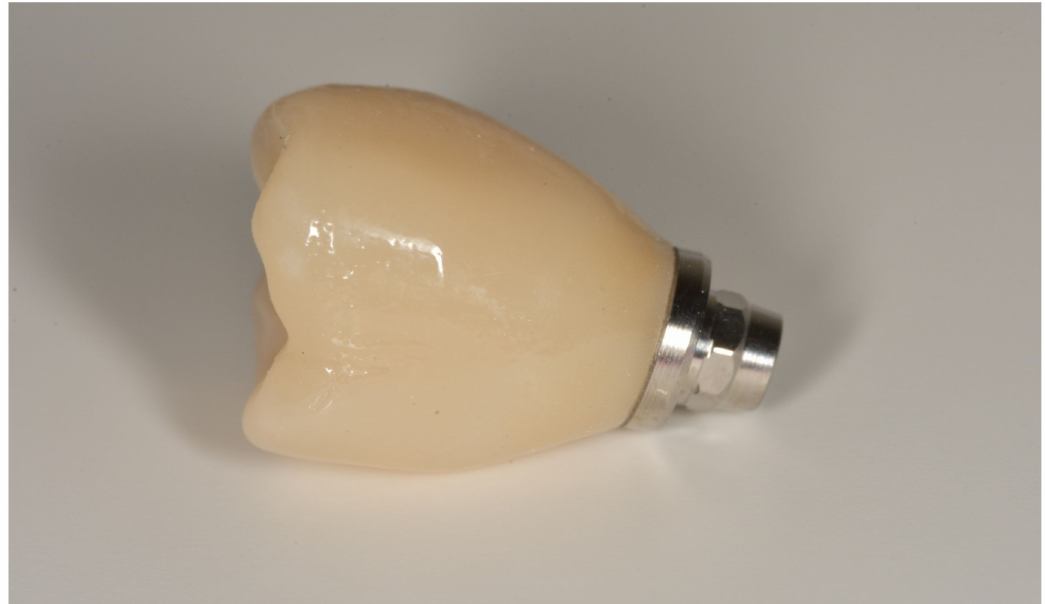
Figure 3. Lateral view of the monolithic CAD / CAM lithium disilicate crown luted to the screw-retained abutment.